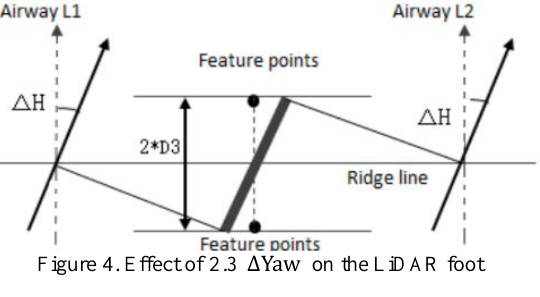
Figure 4. Effect of 2.3